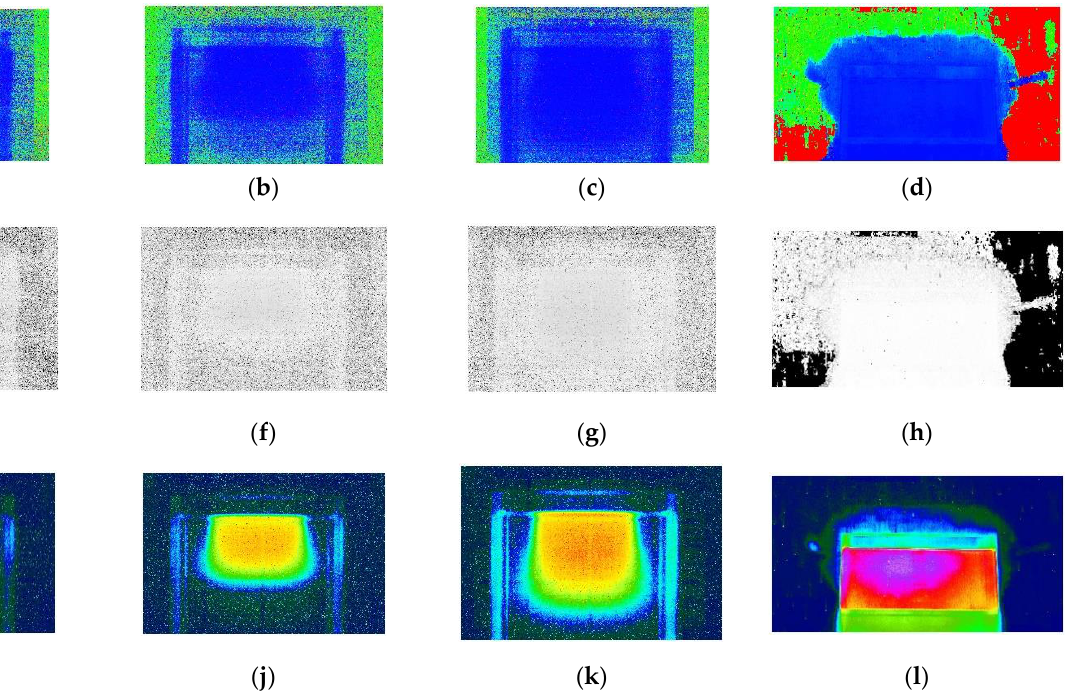
Figure 3. Reconstructed images of fluorescent light of 6, 9, and 12 MeV electron beams and gamma ray (last column ( d , h , l )) in HSV space. ( a – d ) The blue component was dominant in the single H-based decomposition. ( e – h ) A single S basis represents achromaticity. Darker colors represent more achromatic colors, while lighter colors represent more colorful properties. ( i – l ) A single V decomposition displays luminance levels. For visibility, an arbitrary color system was used instead of a grayscale representation. The value of V increases from blue to magenta.